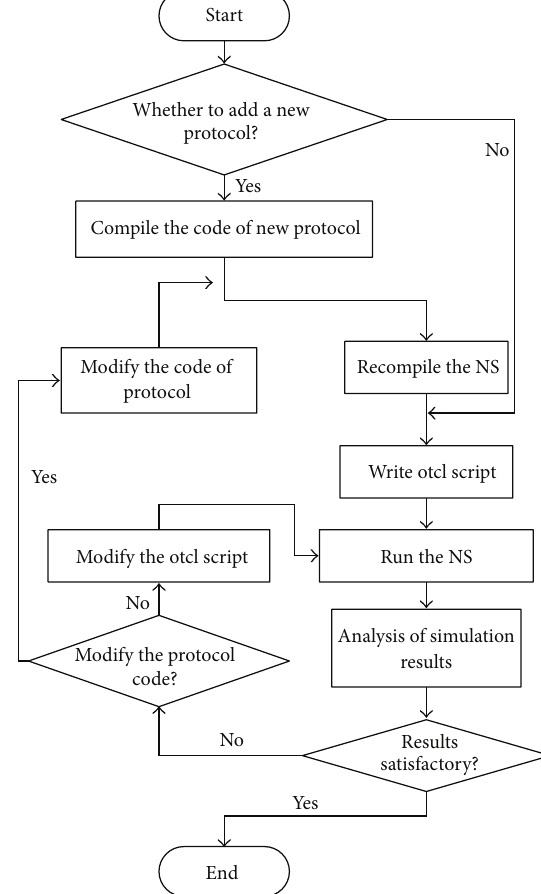
Figure 3: NS2 simulation flow